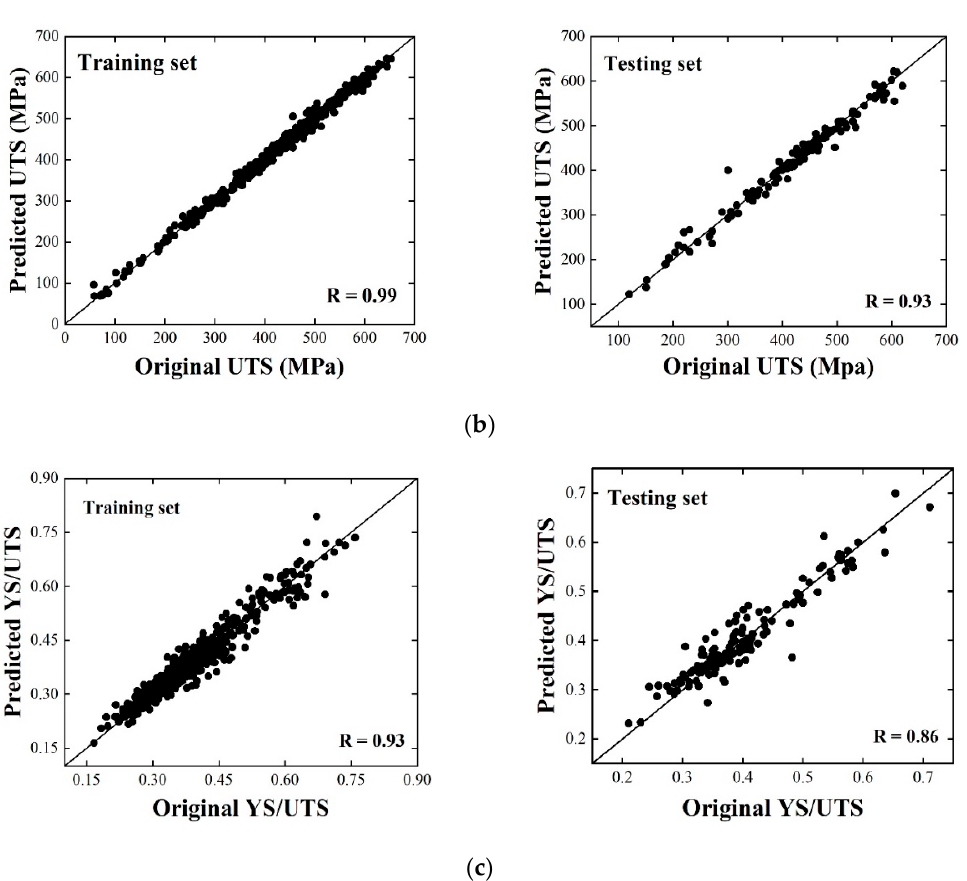
Figure 4. Comparison between the predicted and original values on the training set and testing set for: ( a ) YS, ( b ) UTS and ( c ) YS/UTS ratio. X-axis is the original value of tensile properties, Y-axis is the predicted one and the equation of black line in these figures is y = x (The more points concentrated near the black line, the more accurate the predicted values).